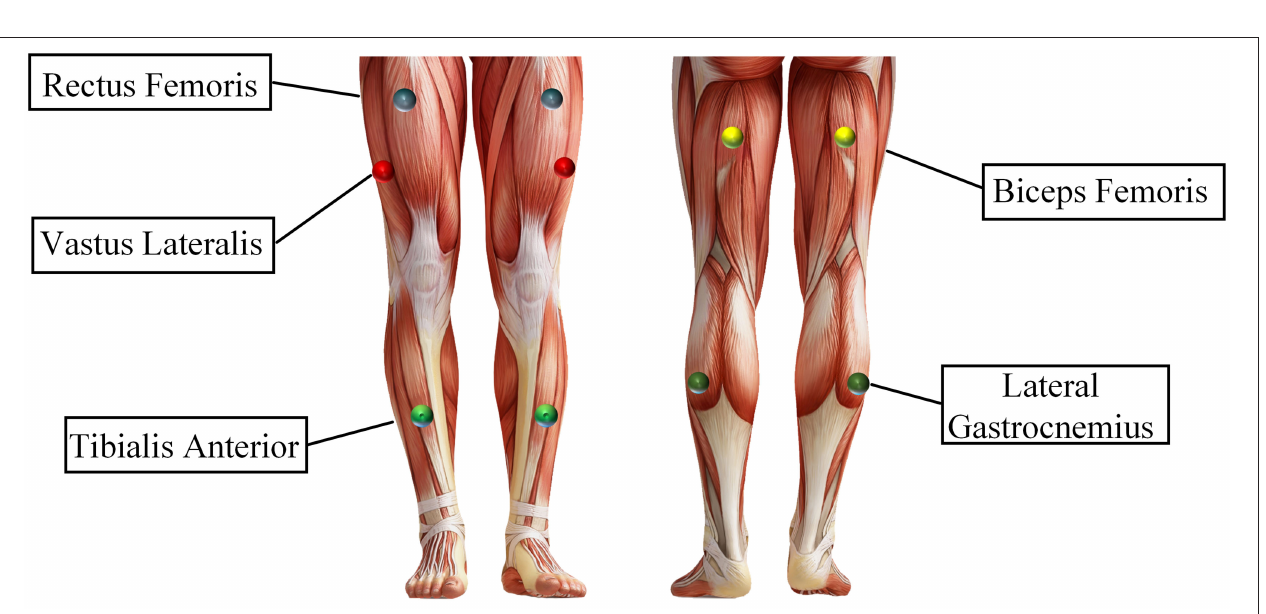
FIGURE 2 | Schematic diagram of sEMG data acquisition experiment. The upper part is the preparation posture of the lower limb movements. The lower part is the experimental acquisition paradigm.